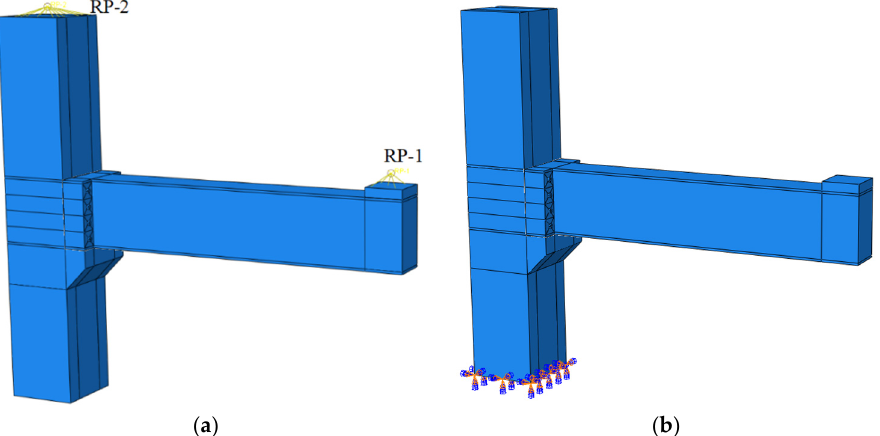
Figure 22. Boundary conditions and loading settings. ( a ) Top of column coupled to end of the beam; ( b ) bottom of a column fixed.